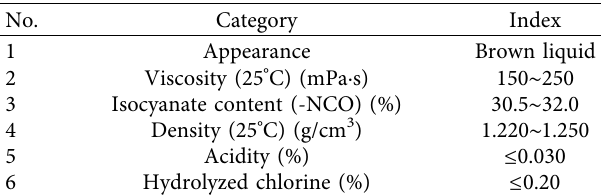
Figure 2: Material composition of WANNATE ® PM-200. Table 2: Physical and chemical properties of WANNATE ® PM- 200.